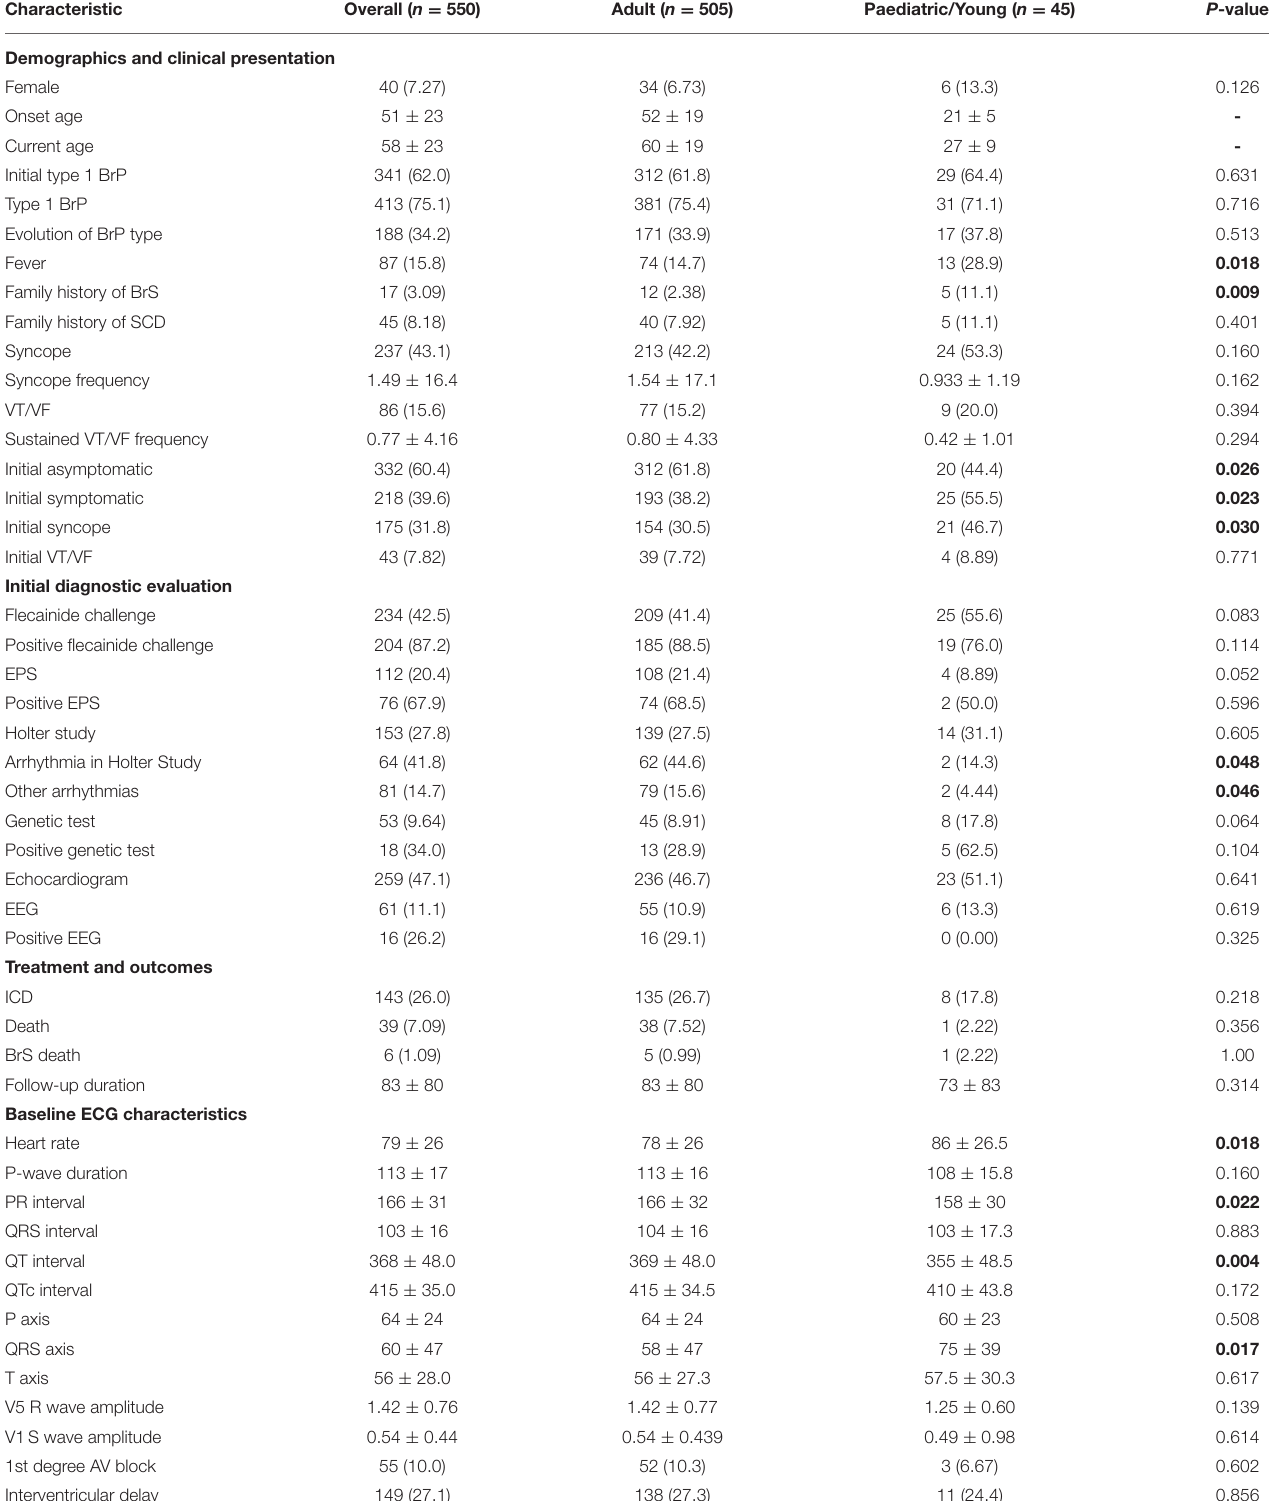
TABLE 1 | Baseline characteristics of the Brugada syndrome cohort.